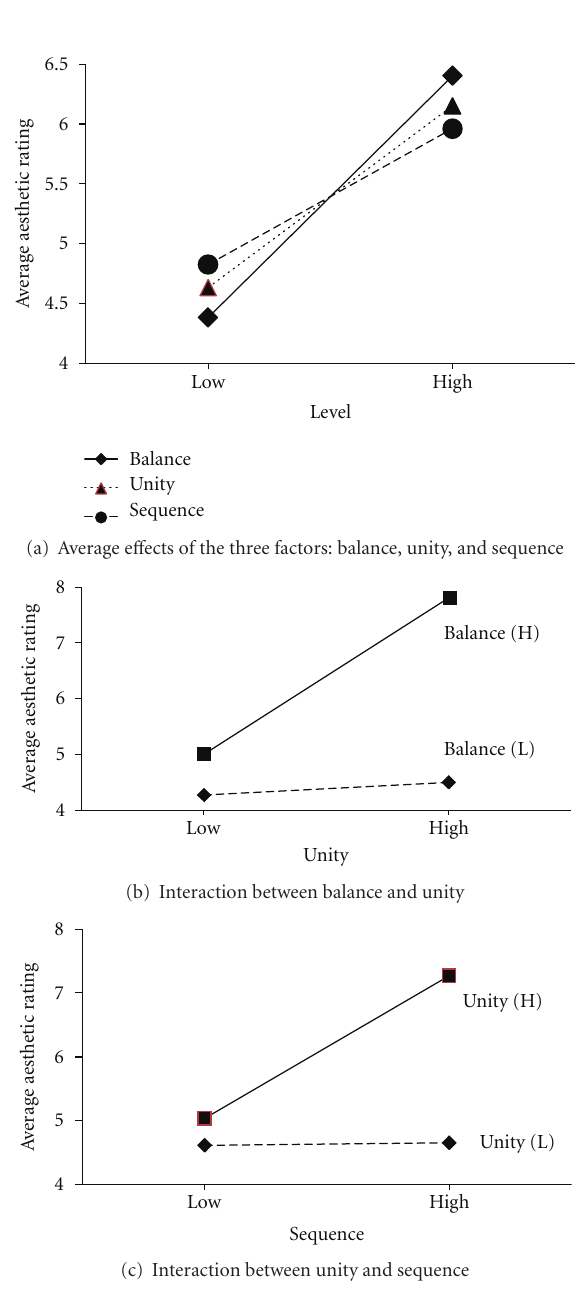
Figure 2: Average e ff ects and interactions